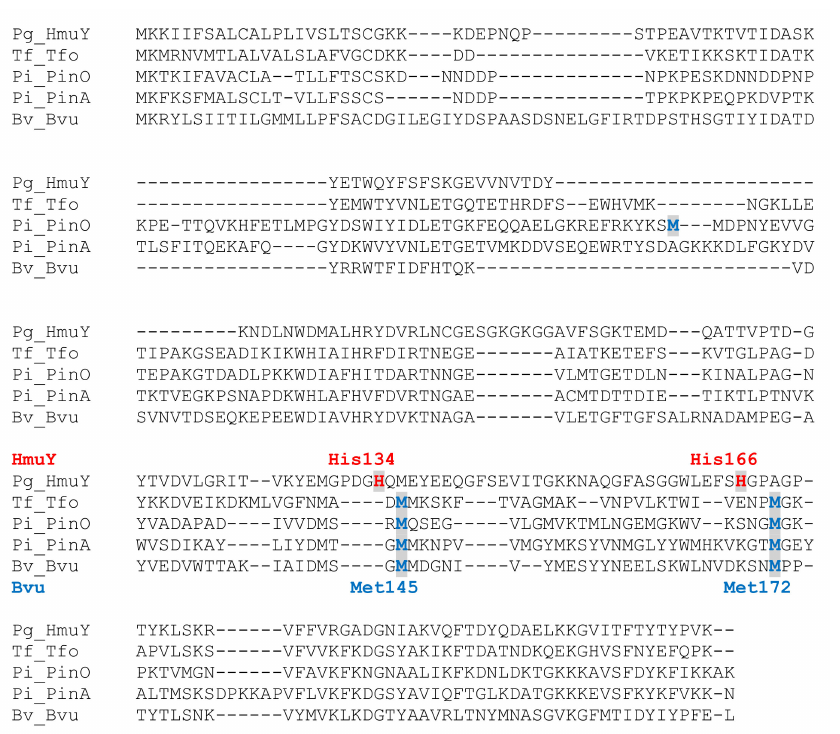
Figure 1. Organization of P. gingivalis hmu operon and hmu -like operon in B. vulgatus. Red arrows indicate genes encoding HmuY and Bvu proteins.